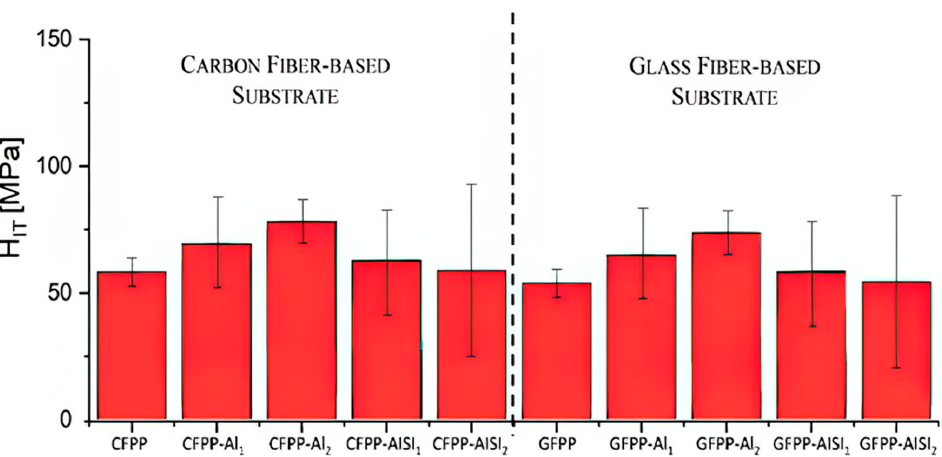
Figure 7. Elastic modulus ( E IT ) comparative chart.